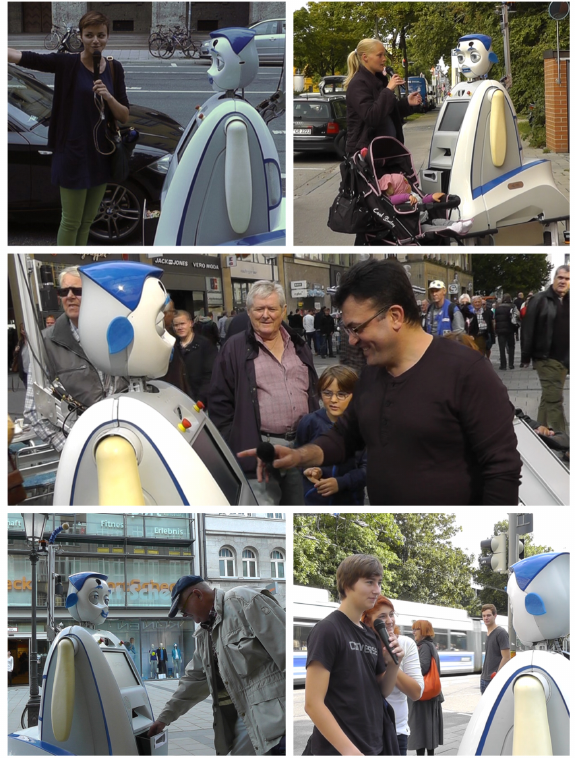
Figure 4: Typical dialogue situations with IURO during the field tri- als.